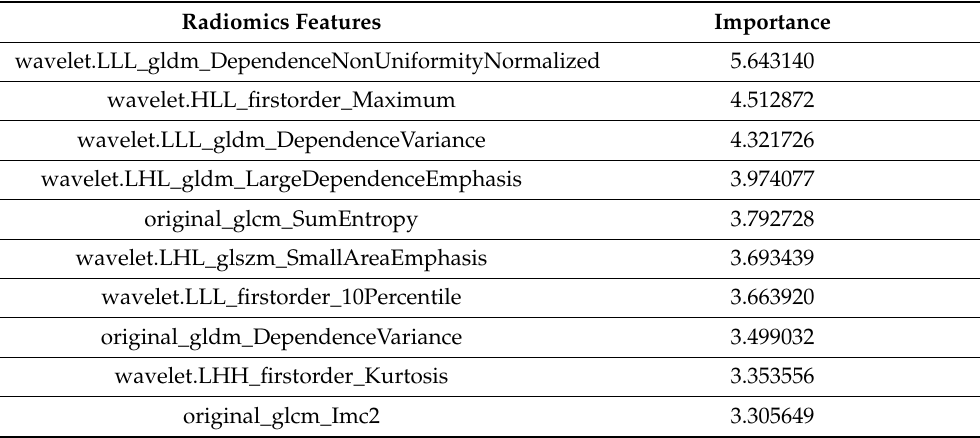
Table 2. Top 10 radiomics features in terms of importance for differentiation between MM and osteolytic metastasis.